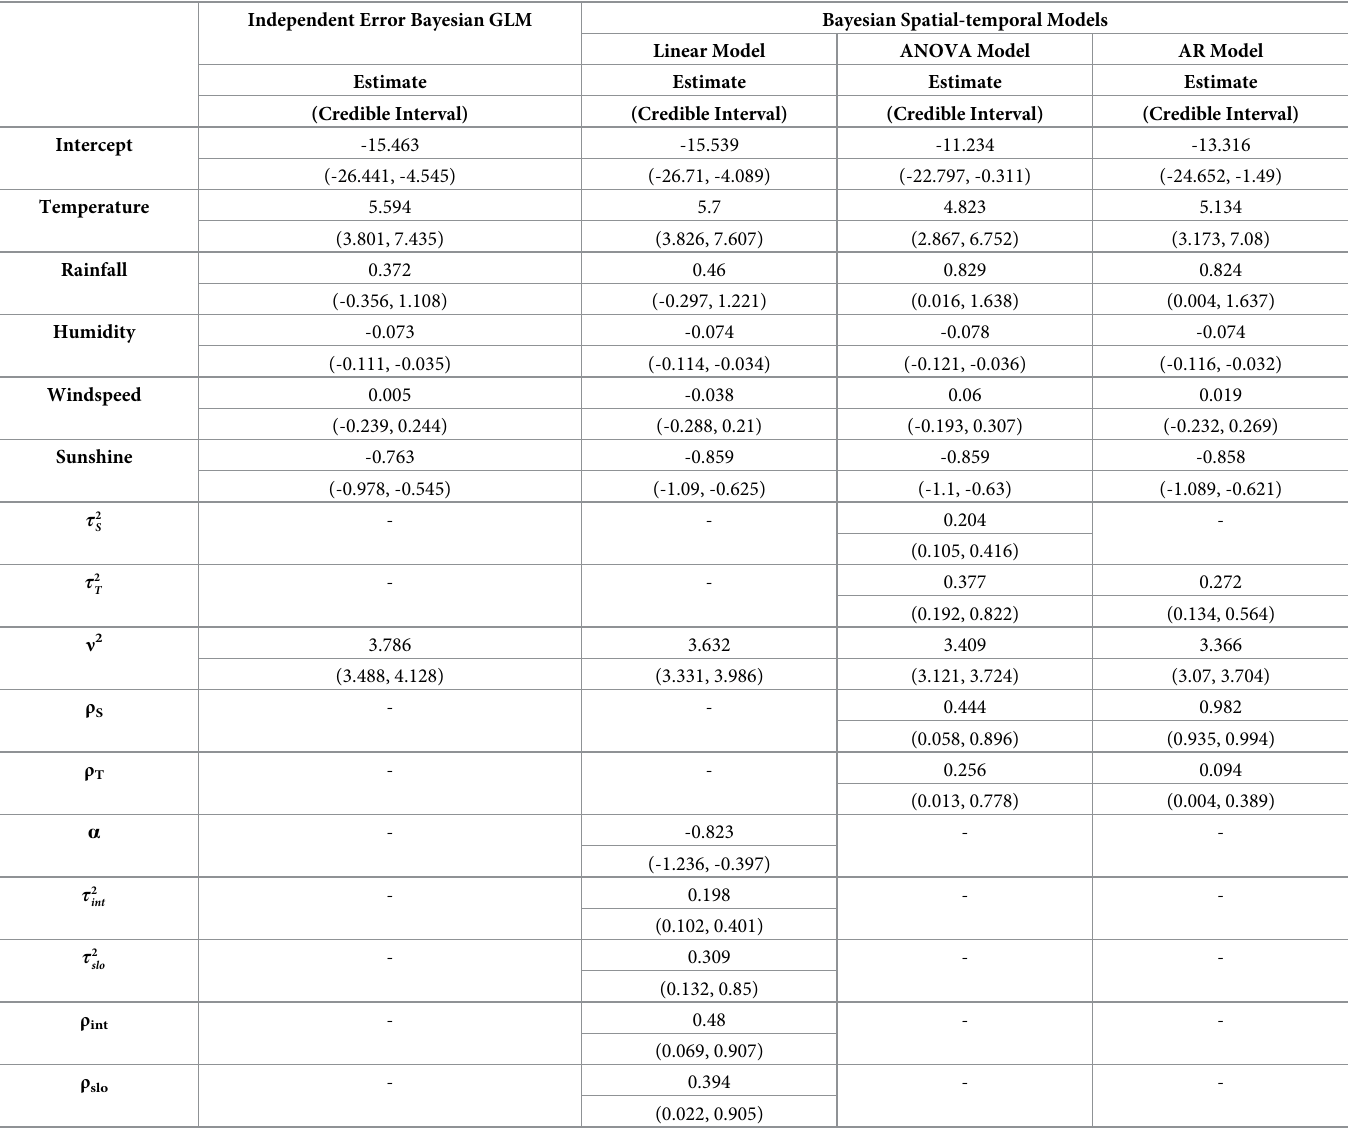
Table 1. Estimated parameters with their credible interval for all proposed